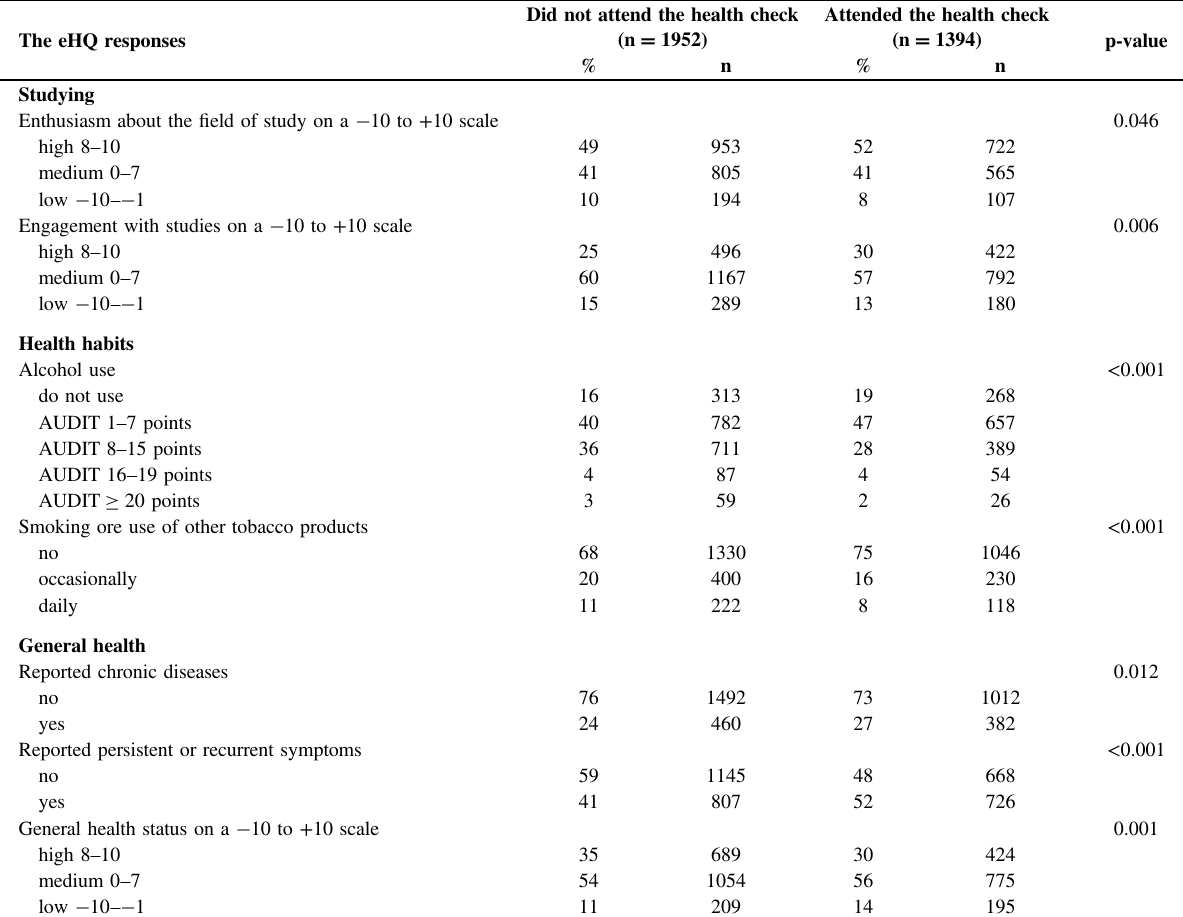
Table 2 The eHQ responses of university entrants referred to a health check by health check attendance. The eHQ